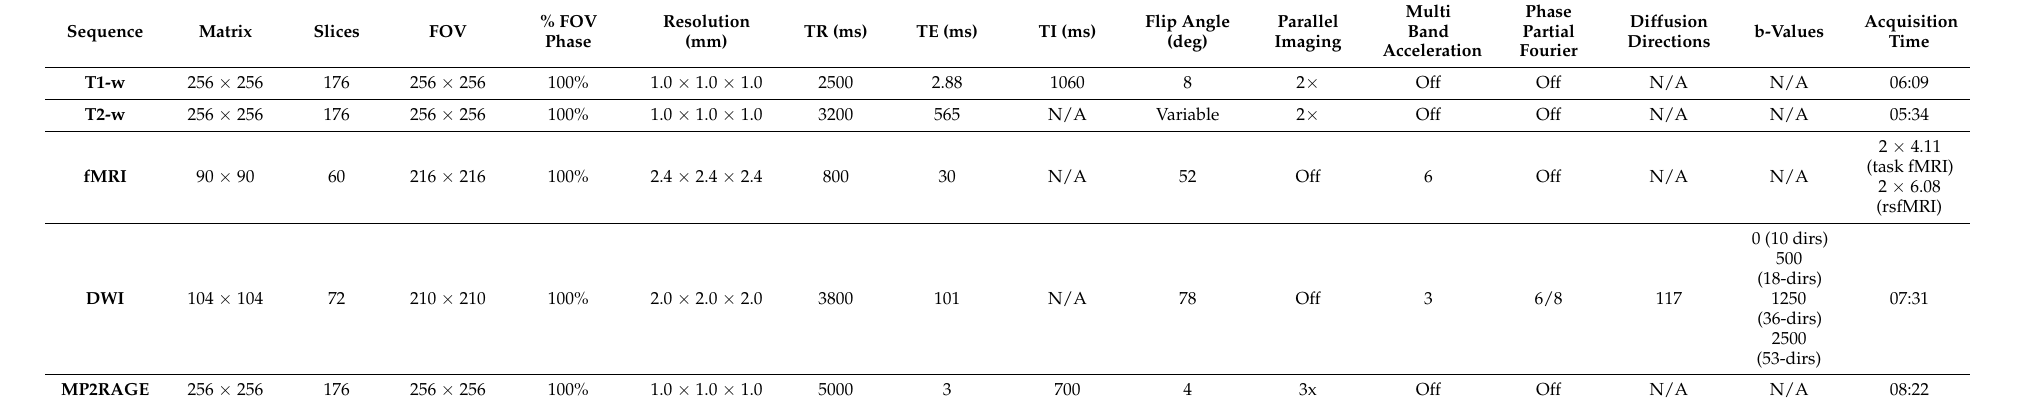
Table 2. Neuroimaging scanning